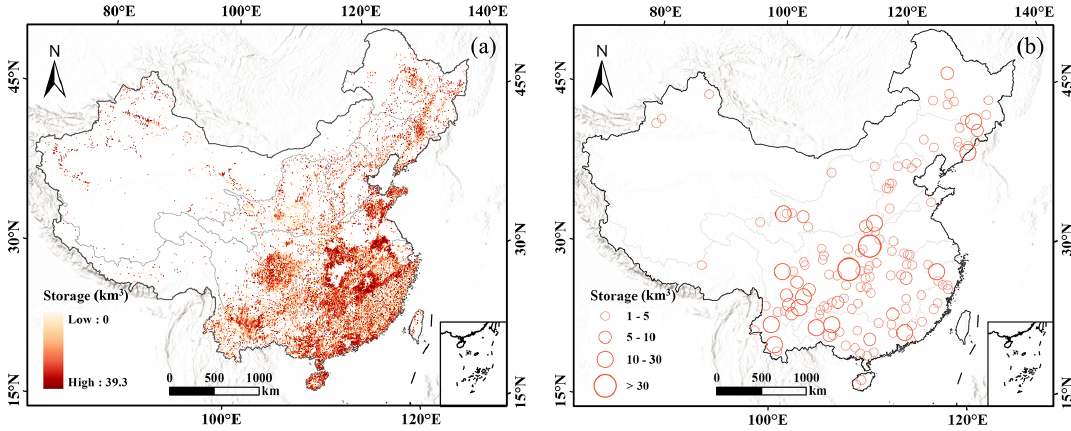
Figure 6. Distribution of reservoir storage capacity in China. Panel (a) shows all 97435 reservoirs in the CRD, which are displayed in gradient color according to the total storage capacity of reservoirs in the 0 . 1 ◦ × 0 . 1 ◦ gridded statistics. Panel (b) shows the 135 reservoirs larger than 1km 3